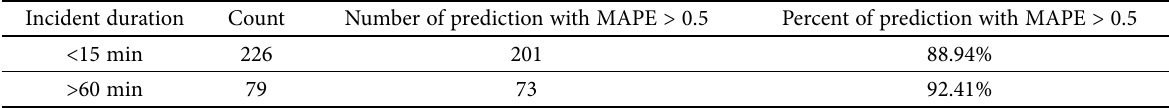
Table 5. Prediction results for incidents lasting longer than 60 min or shorter than 15